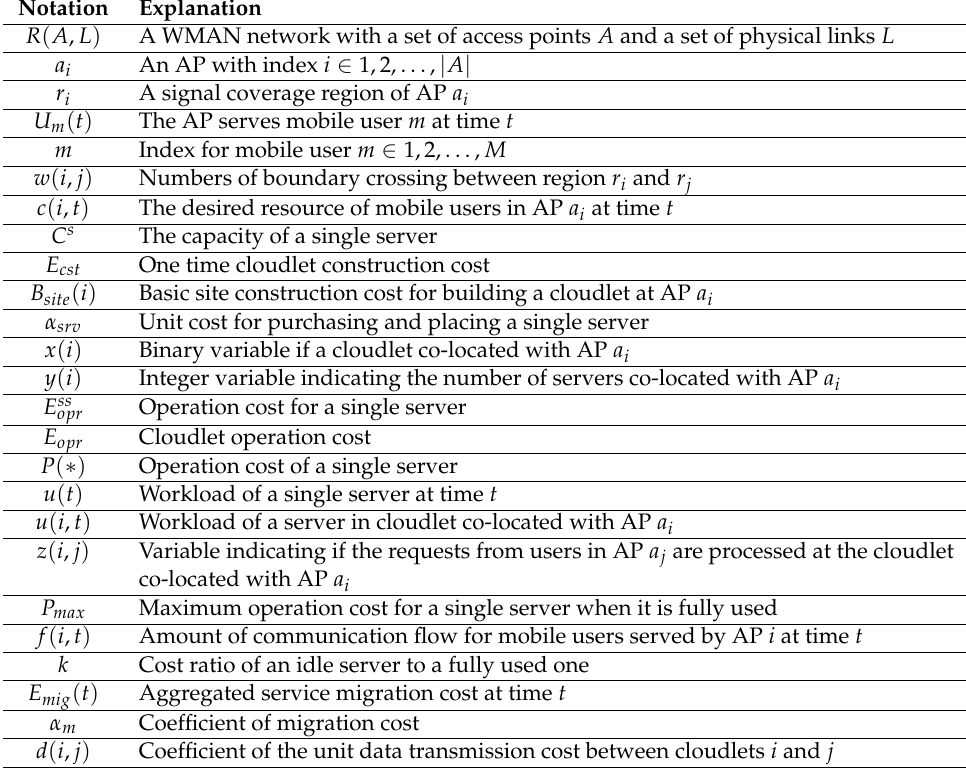
Table 1. Notations